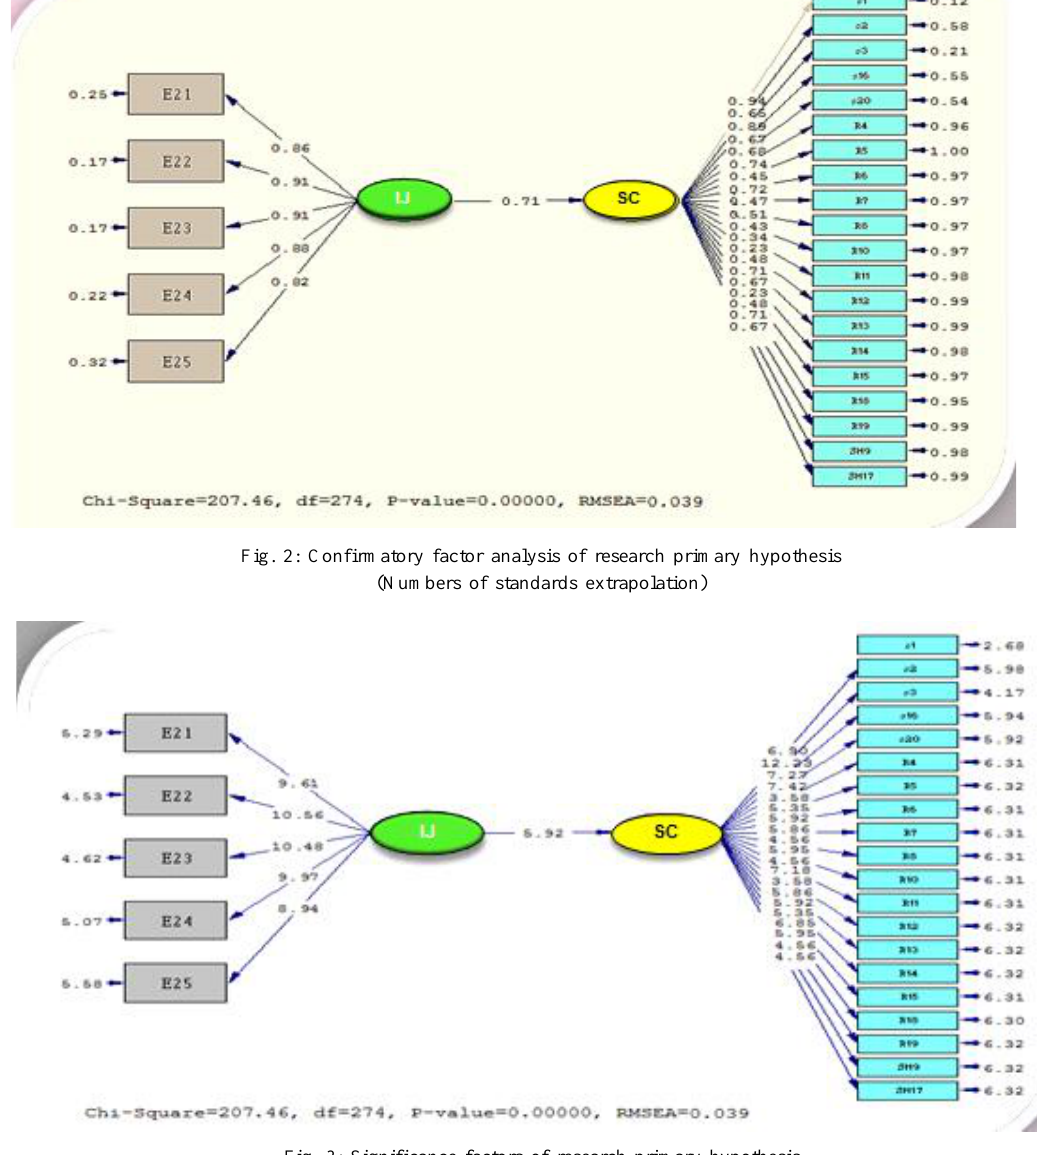
Fig. 3: Significance factors of research primary